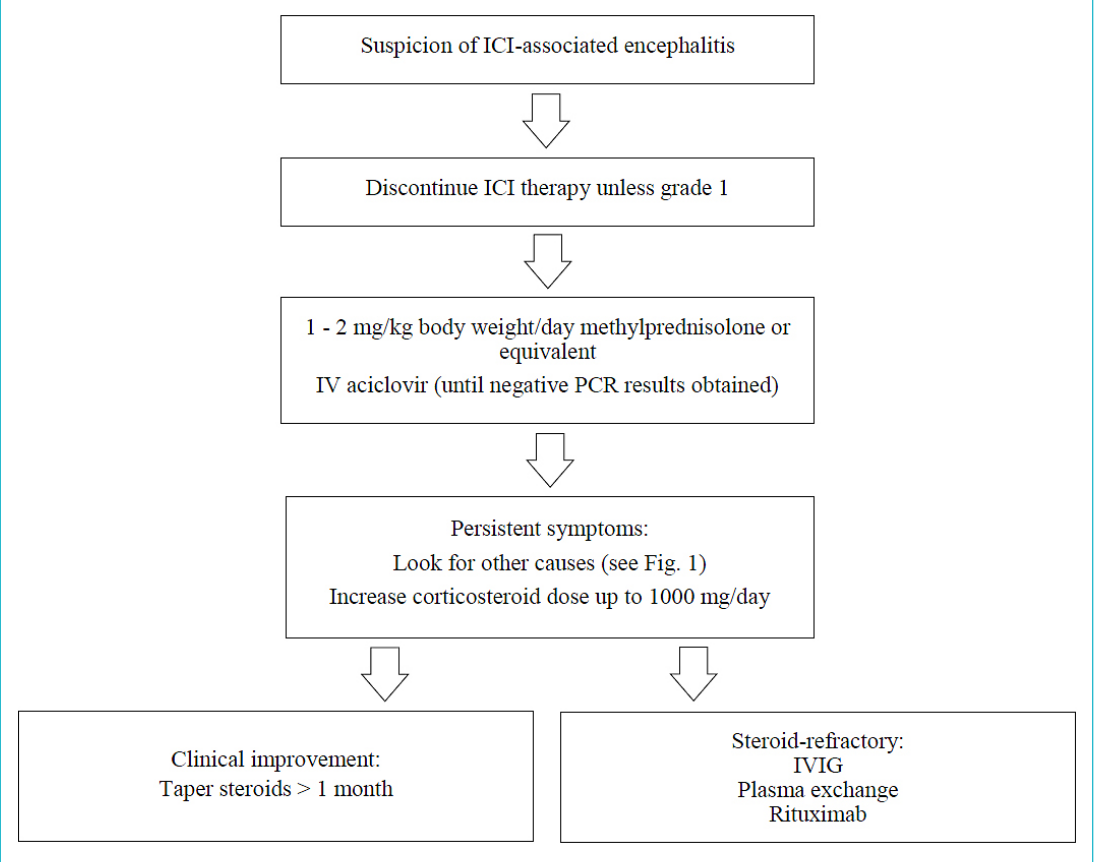
Figure 2: Management of ICI-associated encephalitis.ICI = immune checkpoint inhibitor; ICU = intensive care unit; IV = intravenous; IVIG = in- travenous immunoglobulins; PCR = polymerase chain